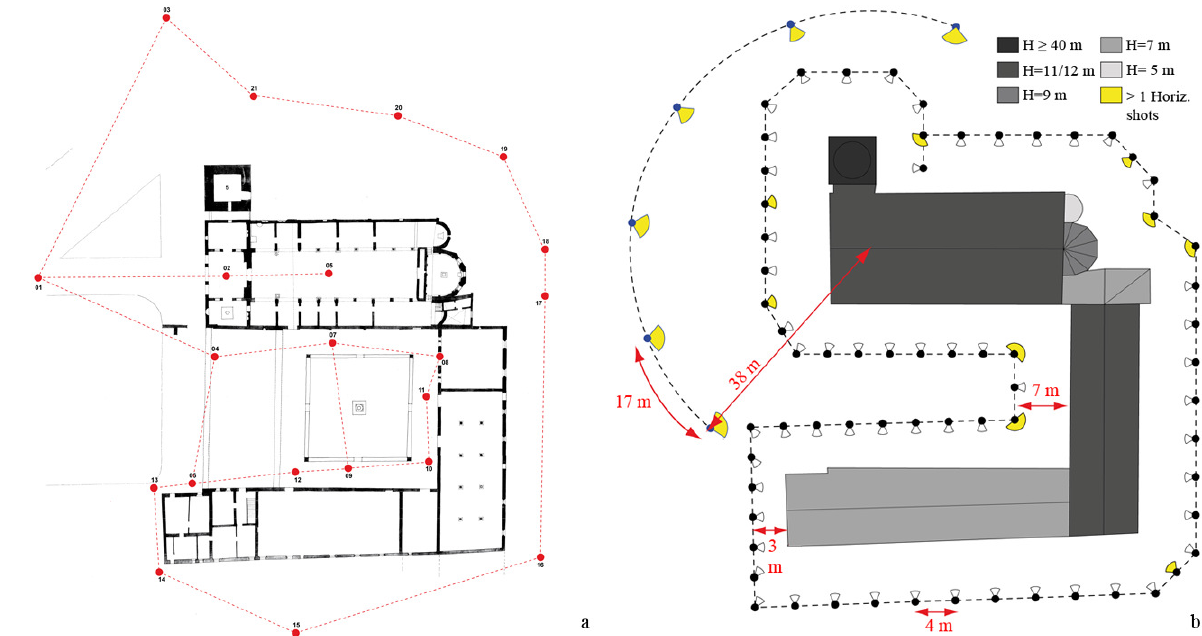
Figure 6. Range-based (a) and image-based (b) survey